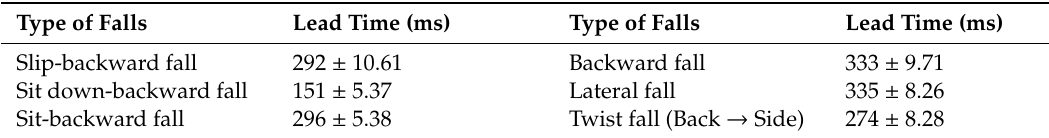
Table 3. Lead times according to type of falls.